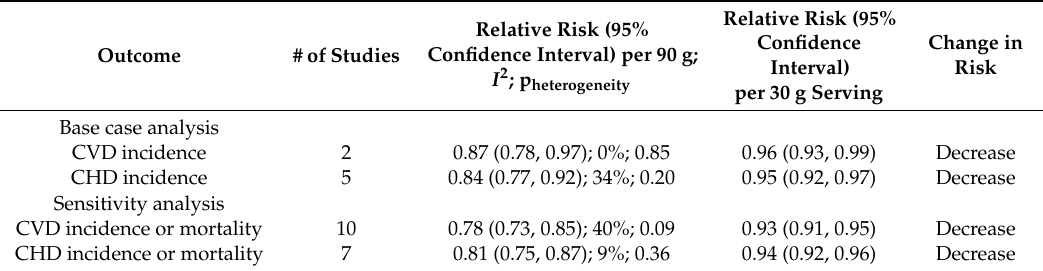
Table 1. Input parameters for reduction in risk of cardiovascular disease and coronary heart disease with consumption of whole